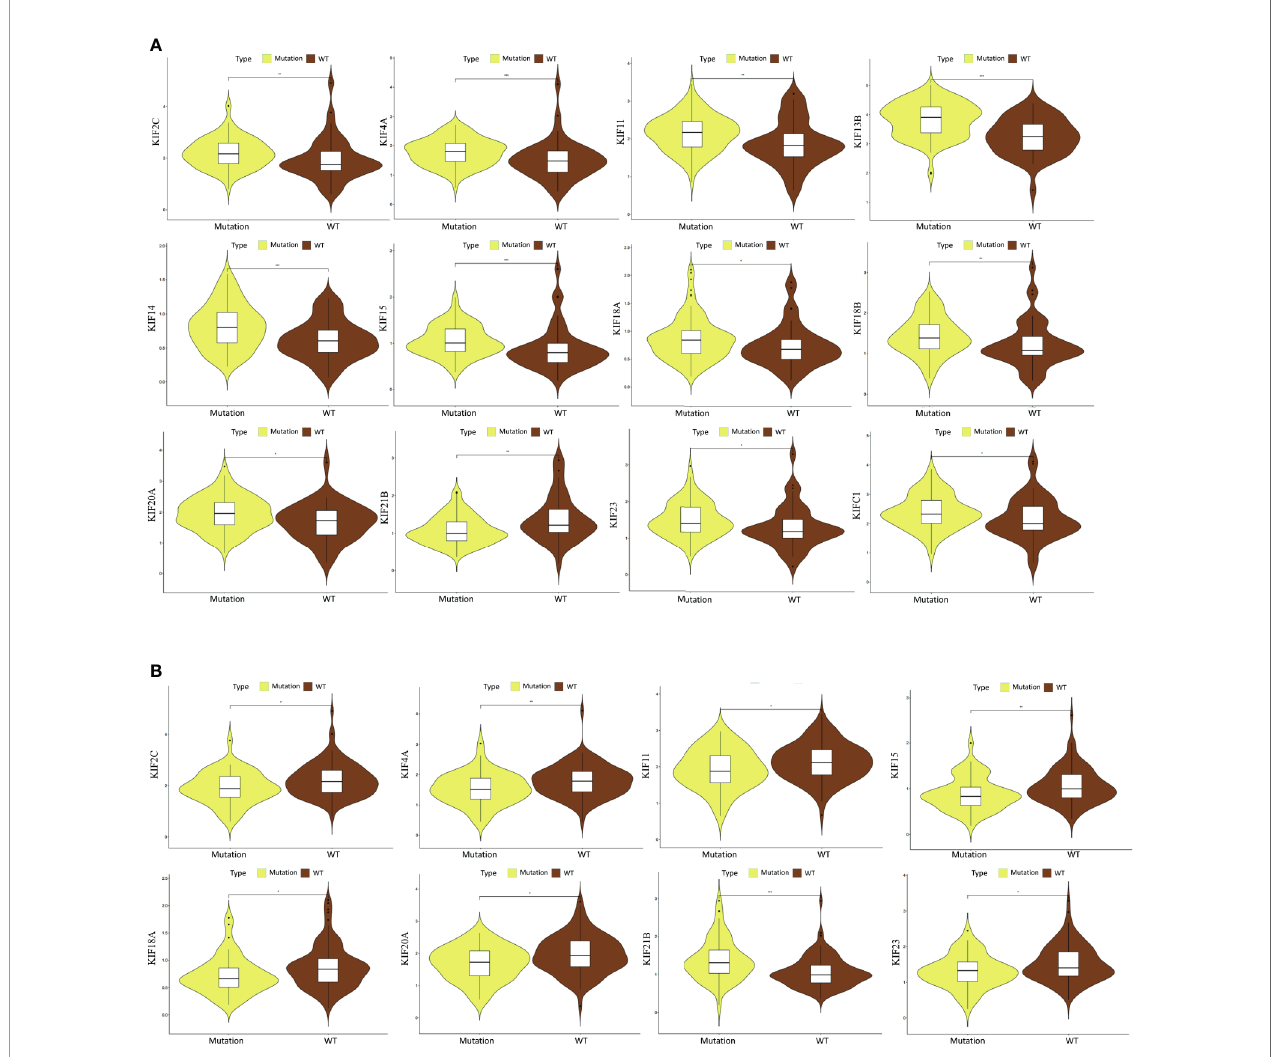
FIGURE 5 | Correlation between prognosis-related KIFs expression and the mutation status of KRAS and TP53. (A) The correlation between KRAS mutation and the expression of prognosis-related KIFs. (B) The correlation between TP53 mutation and the expression of prognosis-related